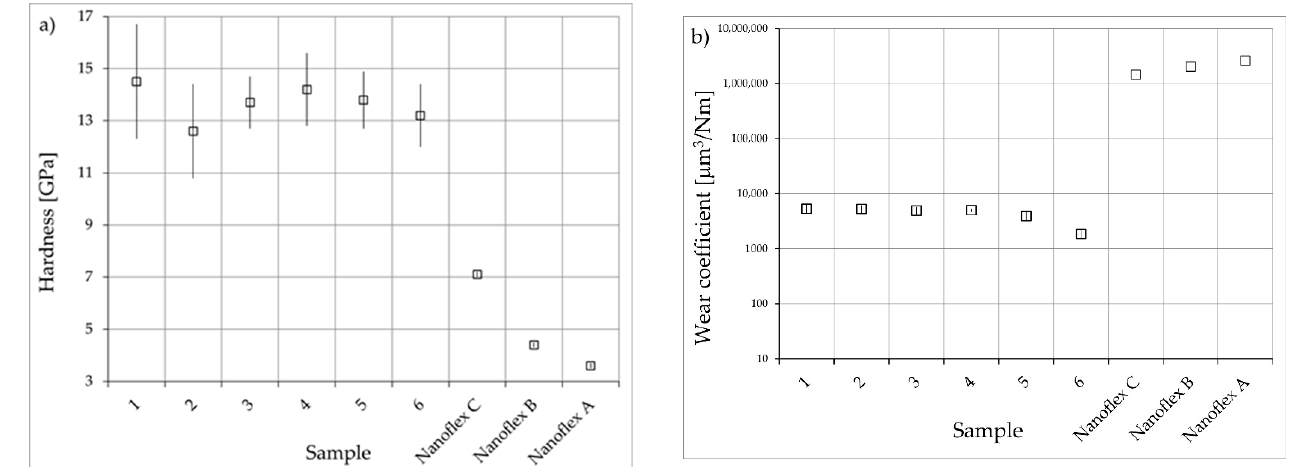
Figure 8. ( a ) Hardness, ( b ) wear coefficient of nitrided layers and Nanoflex steel under conditions A, B and C.